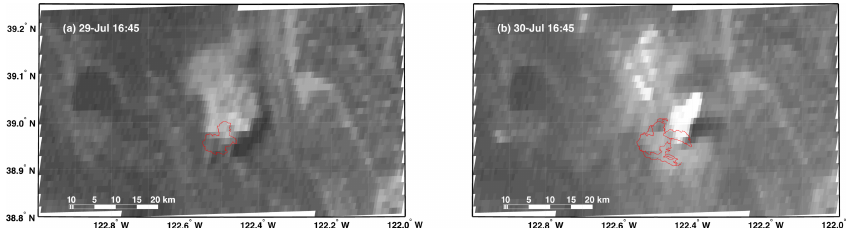
Figure 11. Visible satellite (GOES-15) images showing the difference in the Rocky Fire plume between 16:45PDT on 29 and 30 July. The data show a pyroCu tower on 30 July that is absent on 29 July.